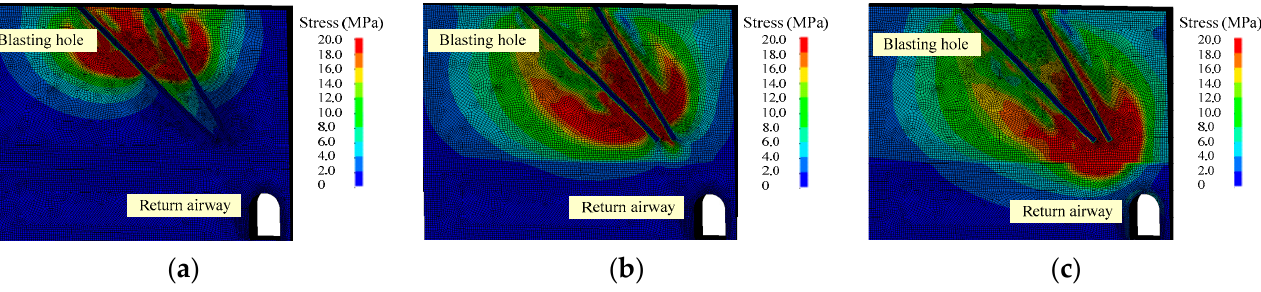
Figure 2. Partial zoom contours of 3-D effective stress at different times: ( a ) t = 500 µ s, ( b ) t = 2000 µ s, and ( c ) t = 4500 µ s. The effective stress reached point 1 at t = 300 µ s and then increased swiftly. The maximum effective stress at point 1 was 12.8 MPa. After t = 2000 µ s, the stress gradually stabilized. A t = 1600 µ s, the maximal effective stress at point 2 was 12.9 MPa. The